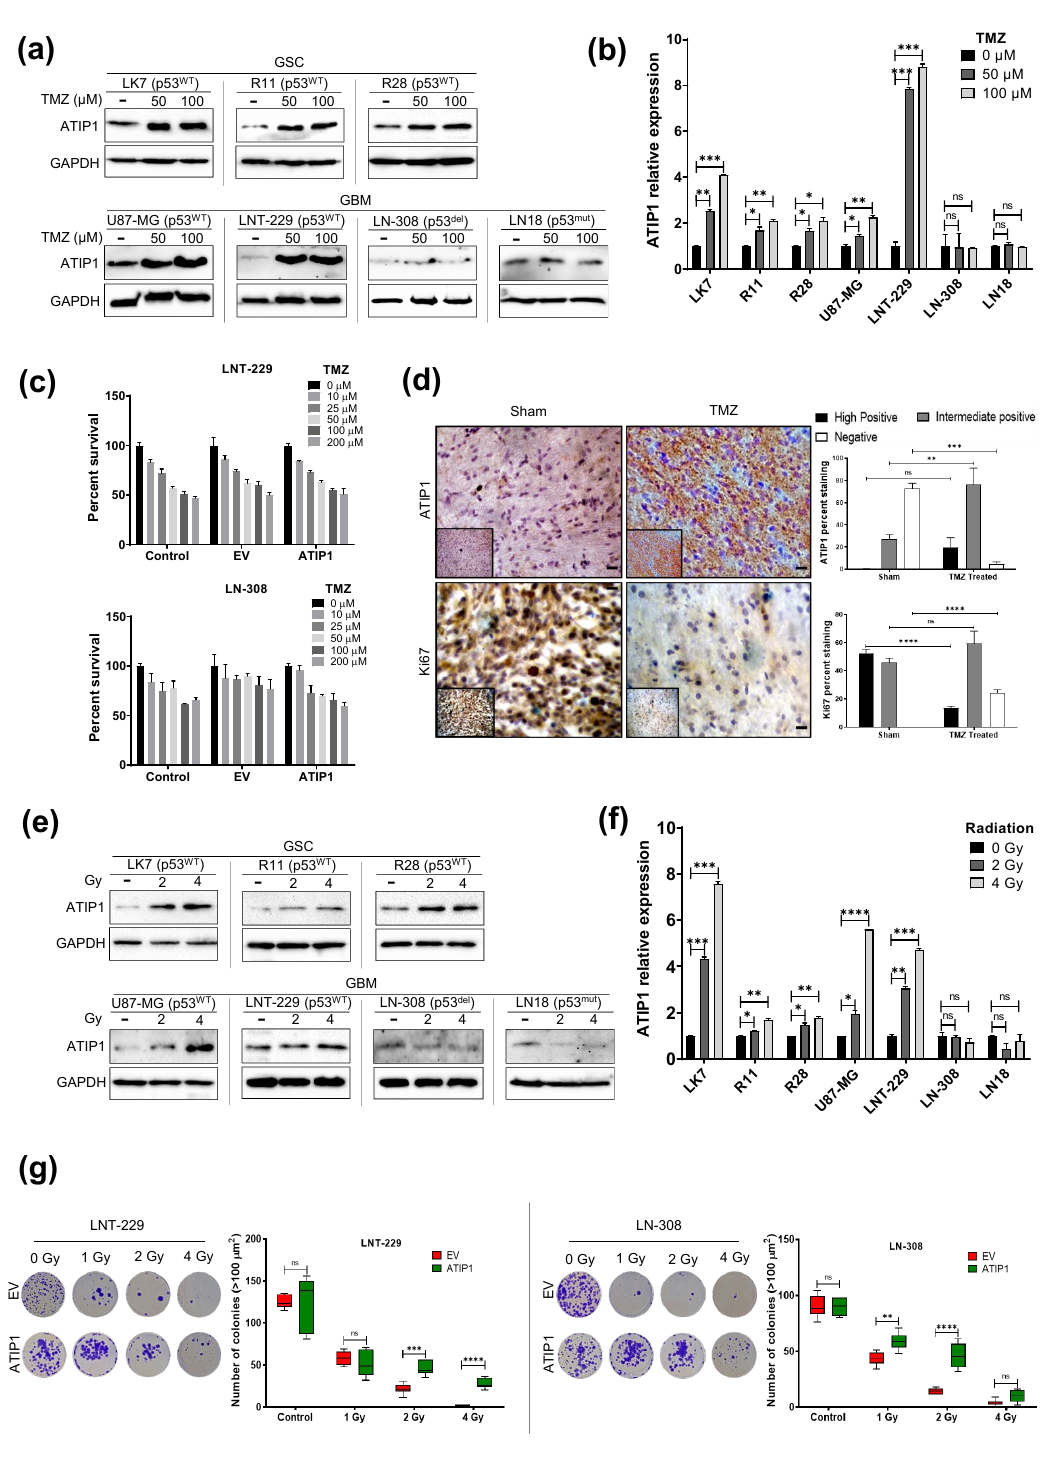
Figure 5. ATIP1 expression is modulated by TMZ and irradiation. ( a ) GBM and GSC cells were treated with TMZ and assessed for ATIP1 protein expression 72 h later. GAPDH serves as loading control (n = 3, one representative experiment is shown). ( b ) Quantification of protein expression after TMZ treatment as indicated in ( a ) (n = 3, SEM; ns, * p < 0.05, ** p < 0.01, *** p < 0.001, **** p < 0.0001). ( c ) Clonogenic survival of TMZ treated parental (control), pcDNA3.1 (EV) and pcDNA3.1-ATIP1 (ATIP1) stably transfected LNT-229 (upper panel) and LN-308 cells (lower panel, n = 3, SEM). ( d )